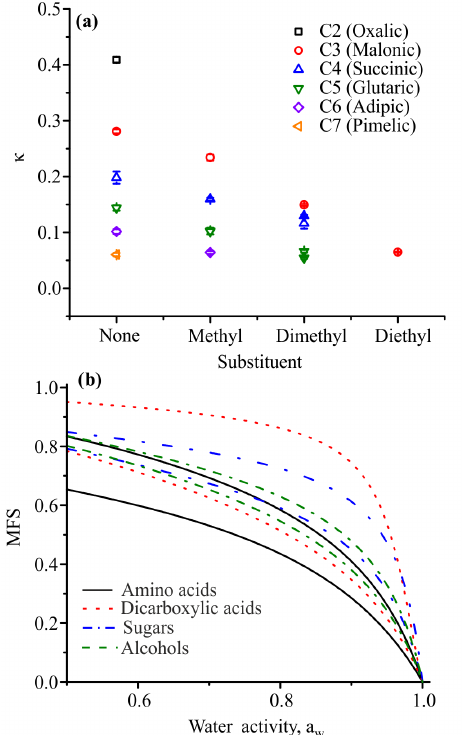
Figure 11. (a) κ values at a water activity of 0.95 are plotted as a function of increasing length of substituent and carbon backbone. (b) Generalised equilibrium hygroscopicity curves are presented as a function of compound class. Upper and lower hygroscopicity lim- its for each compound class have been fitted using the isotherm model discussed in Dutcher et al. (2013) (coefficients available in Table S0.1).